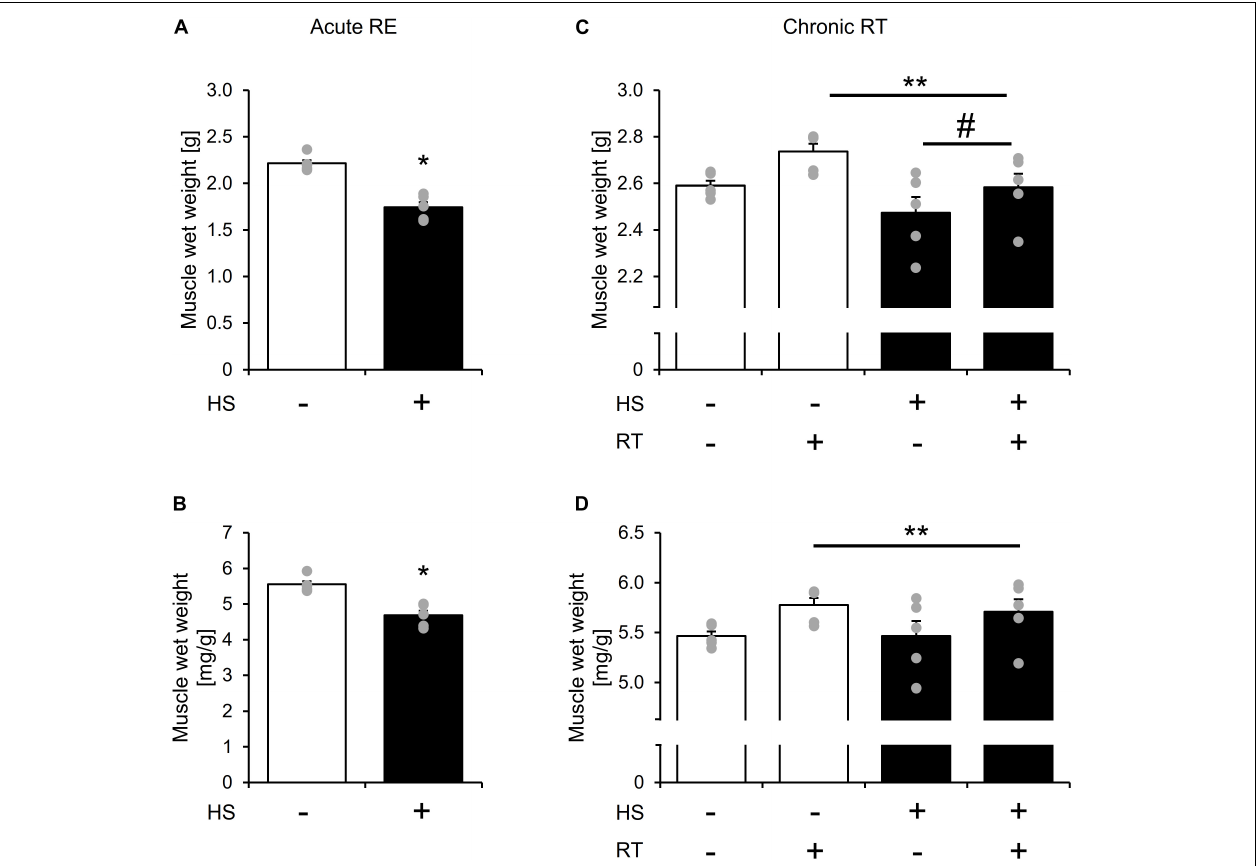
FIGURE 2 | The effect of 14-days of hindlimb suspension and 10-bouts of RT on gastrocnemius muscle mass per body weight. Gastrocnemius muscle wet weight after 14-days of hindlimb suspension (A,B) . Gastrocnemius muscle wet weight after chronic RT (C,D) . HS: hindlimb suspension. RT: resistance training. Values are means ± SE ( n = 5/group). *: p < 0.05 vs. CON. Black line with **: main effect of RT ( p < 0.05). Black line with # : main effect of HS ( p <